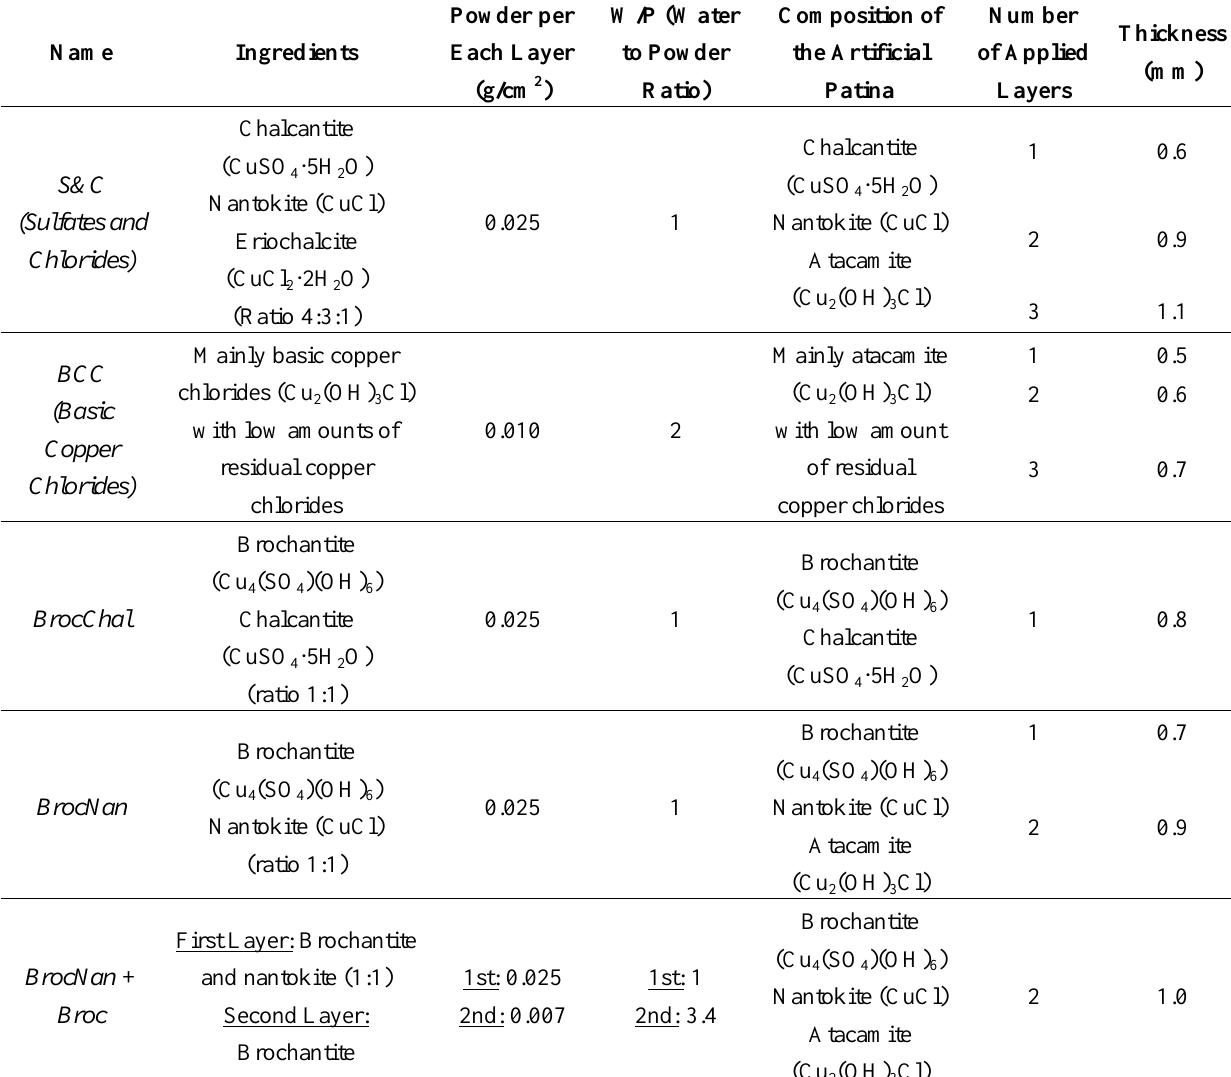
Table 1. List and preparation features of the artificial